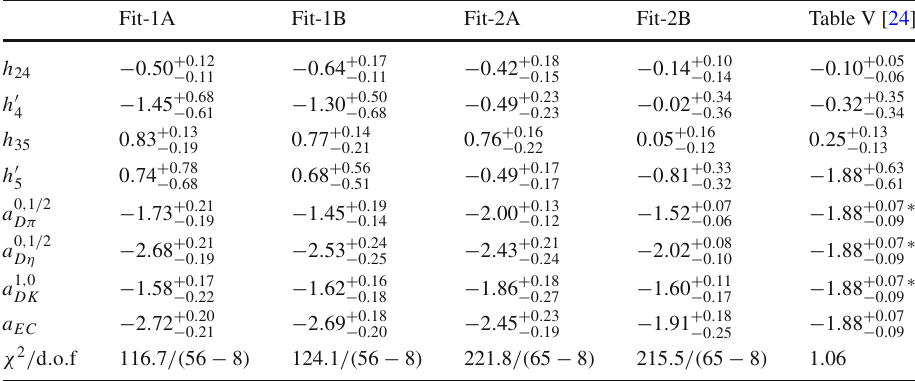
Fit-1A Fit-1B Fit-2B Table V